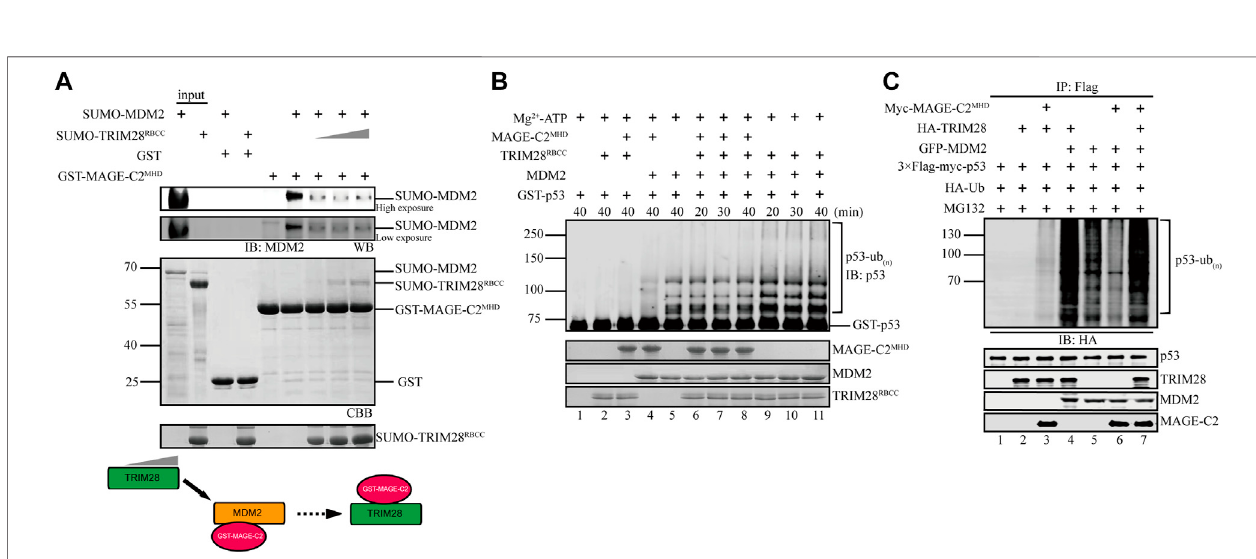
FIGURE 4 | TRIM28 breaks the interaction between MAGE-C2 and MDM2 to promote p53 ubiquitination. (A) GST pulldown assay was used to validate the interaction relationship between TRIM28, MAGE-C2, and MDM2. MDM2 fi rst bound to GST – MAGE-C2 on GST beads, and then TRIM28 was gradiently added. Beads with samples were immunoblotted with the MDM2 antibodies. (B) In vitro ubiquitination assay. His-ubiquitin, ubiquitin E1, UbcH5B E2, Mg-ATP, GST-p53, and the indicated MAGE-C2, MDM2, and TRIM28 proteins were incubated for speci fi c time at 37 ° C and detected by using anti-p53 immunoblotting. (C) Ubiquitination assay in cells. HEK293T cells were transfected with HA-ubiquitin and the indicated plasmids. The level of p53 ubiquitination was determined by using anti-Flag M2- agarose redbeads puri fi cation and anti-HA Western blot.